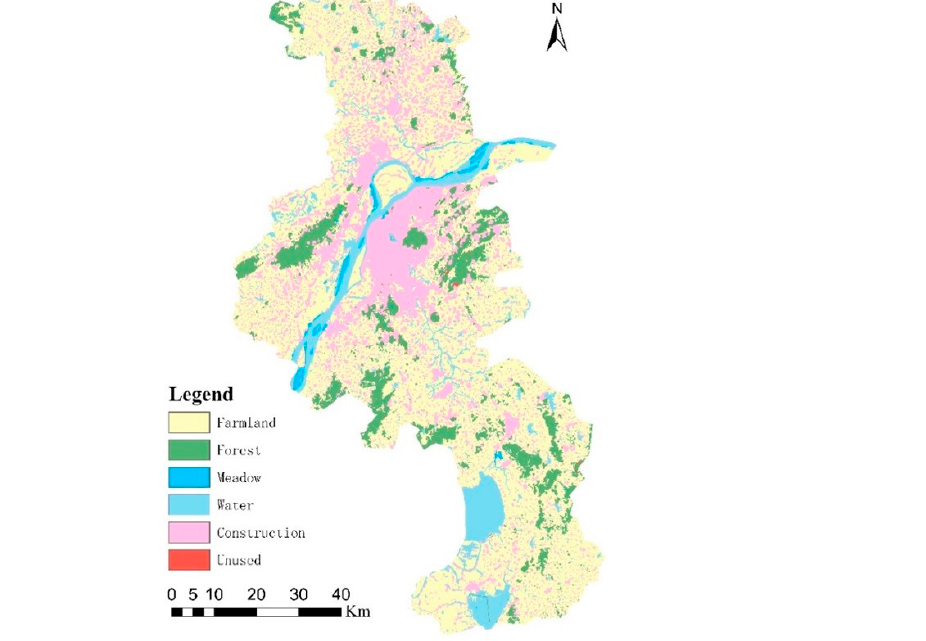
Figure 9. Simulated LU pattern in the year 2005 by the proposed CA model.